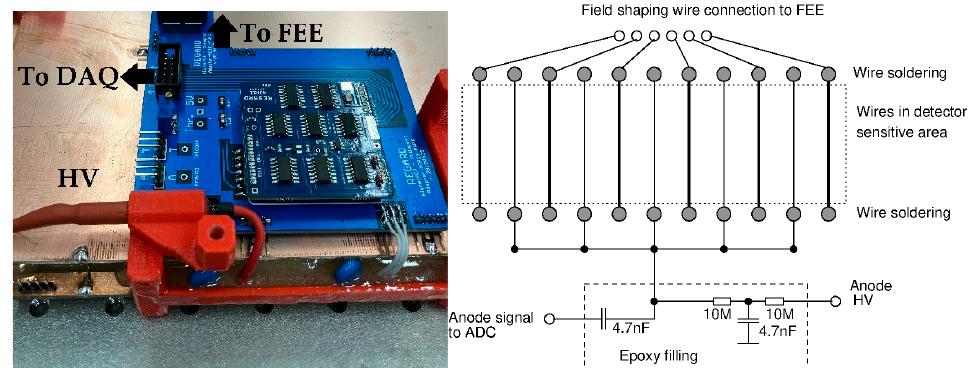
Figure 3. Schematics of high voltage connection and the signal extraction (bottom of left panel) and the actual design with the ADC-card adapter. Note the gluing that covers all components on high voltage, indicated with the dashed line box on the right panel. The ADC-card acts as amplifier, and transmits the converted anode wire amplitude information to the DAQ [14].